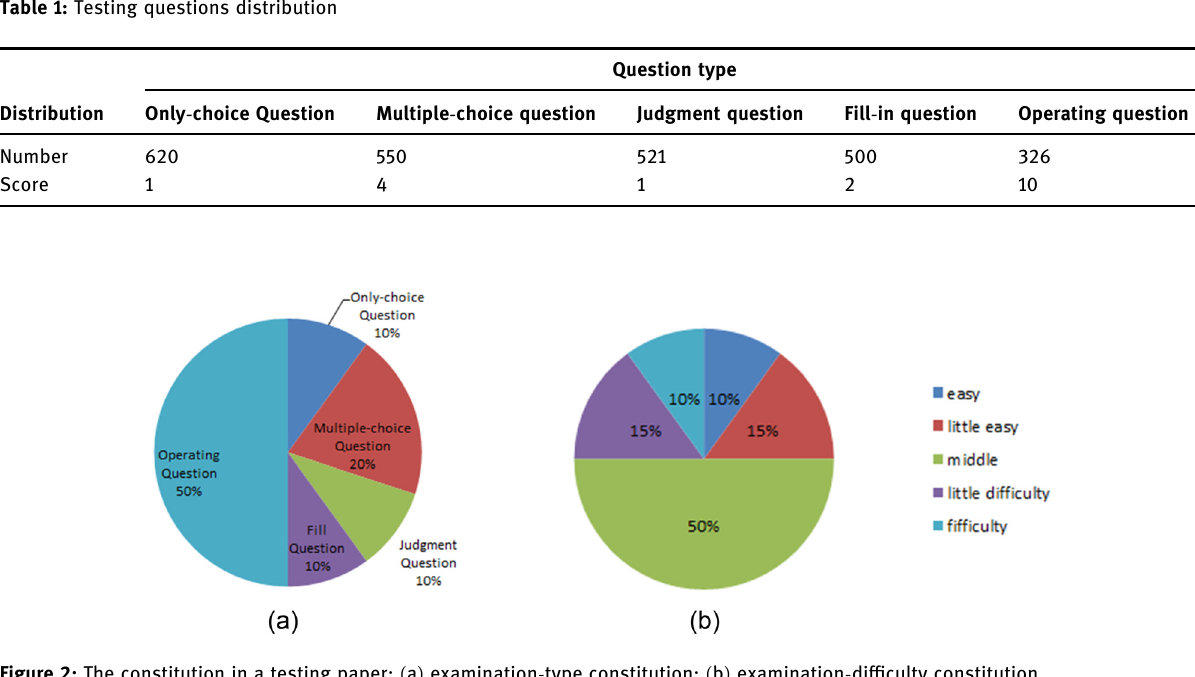
Table 1: Testing questions distribution